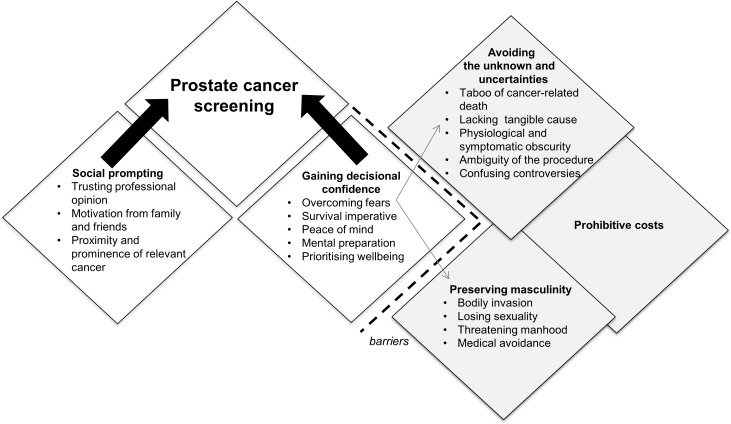
Thematic schema.